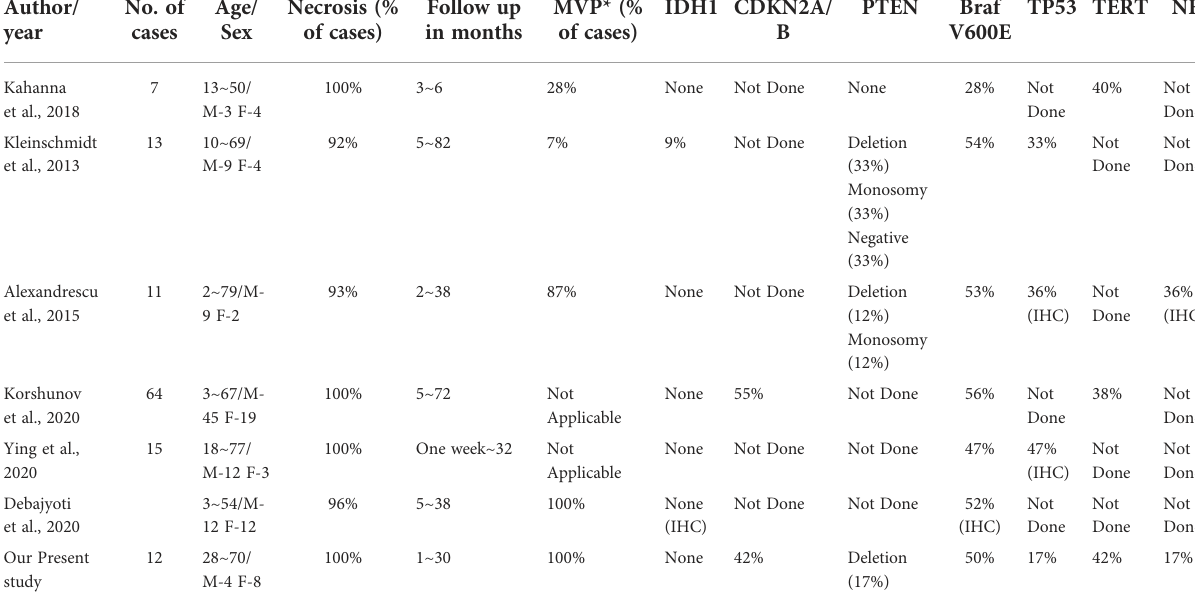
TABLE 3 Review of previous studies including mutational